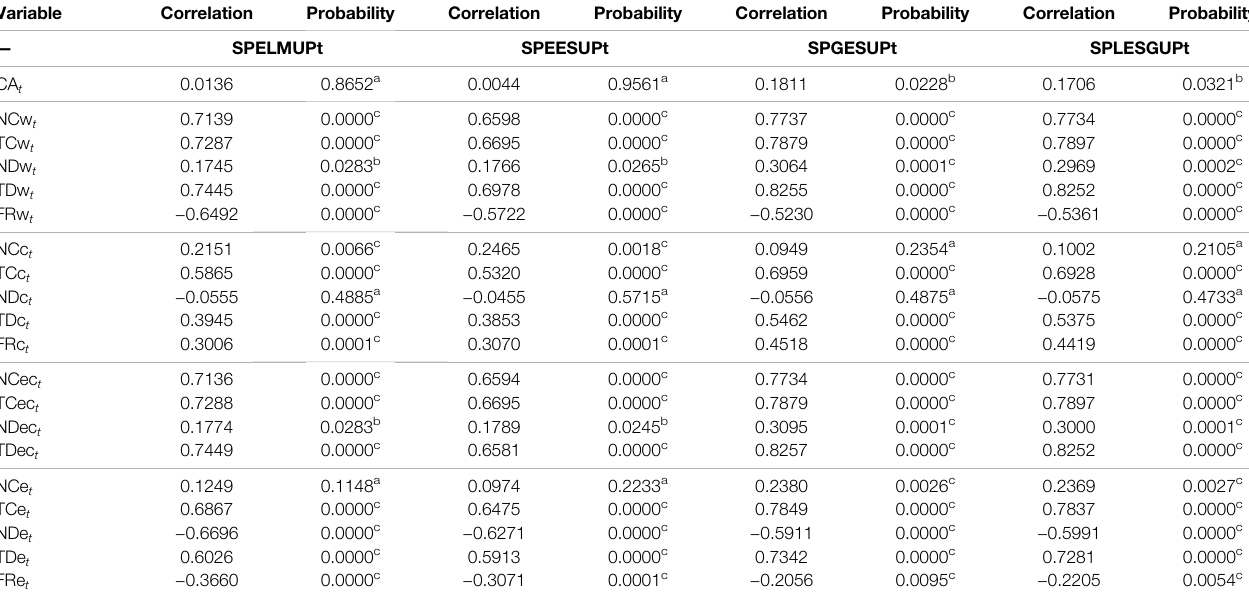
TABLE 5 | Correlation of selected fi nancial market indices and COVID-19 related variables.